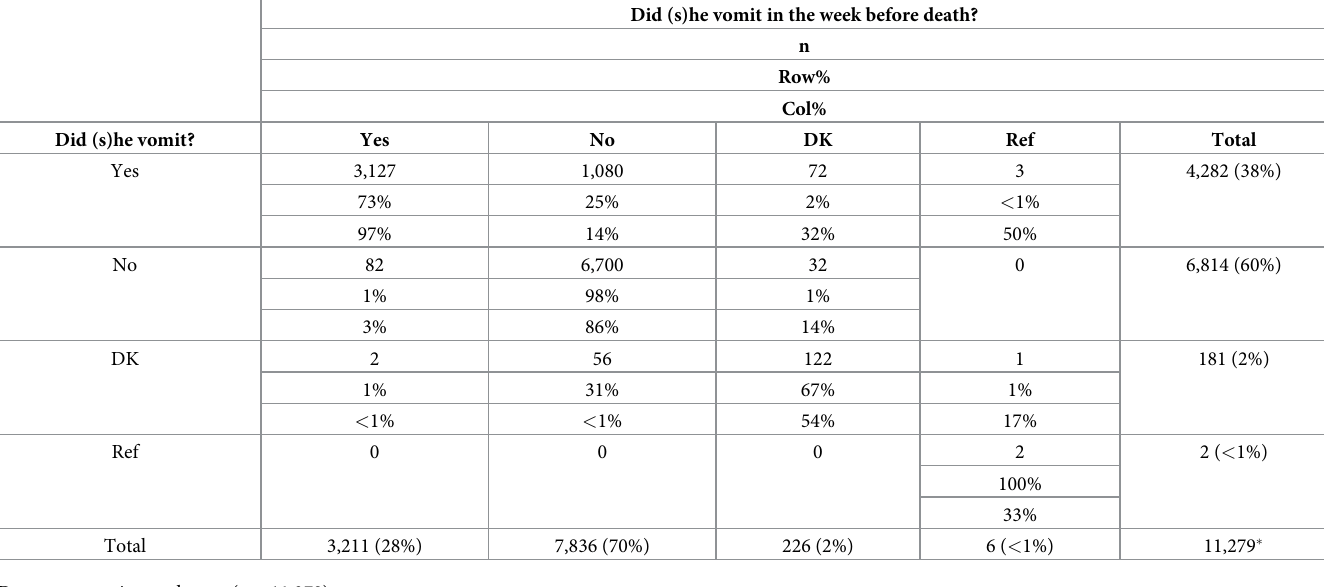
Table 2. Crosstabulation of responses to questions, “Did (S)he vomit?” and “Did (s)he vomit in the week before death?” Did (s)he vomit in the week before